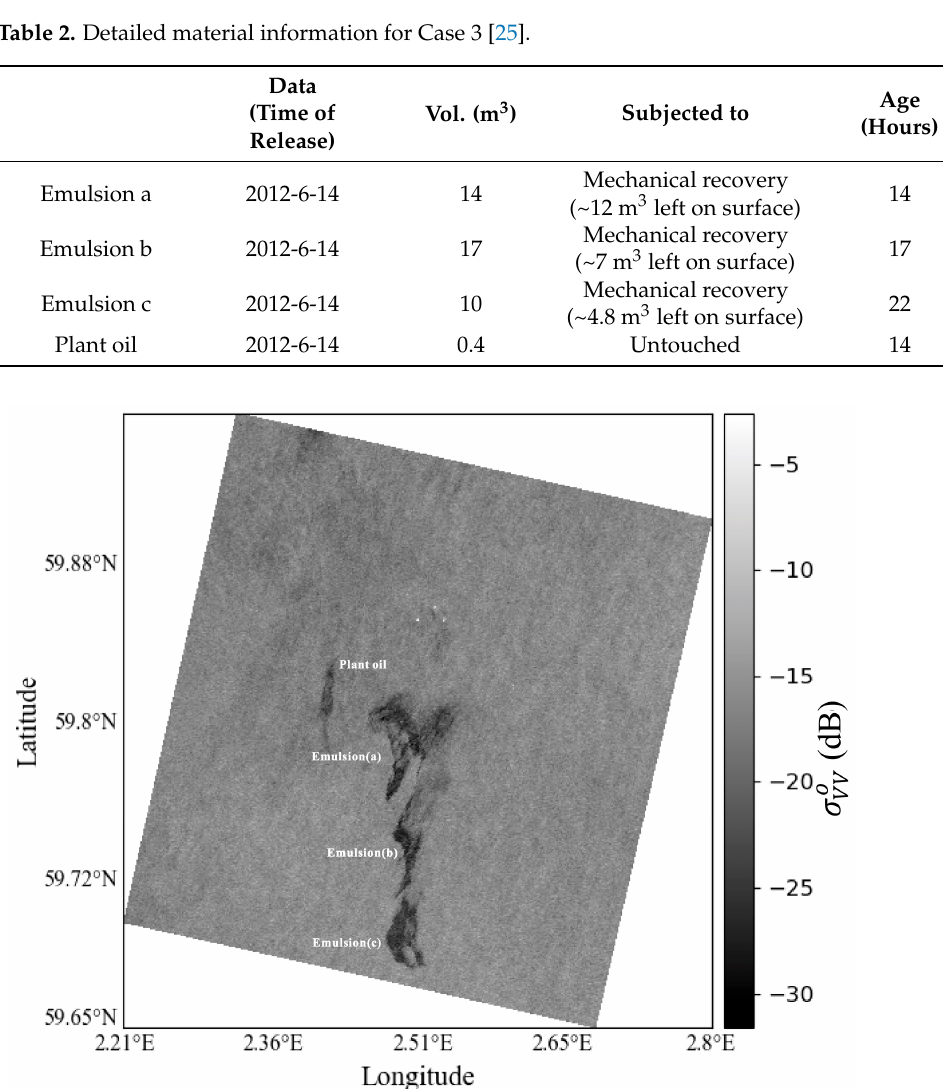
Figure 2. Detailed material information for Case 3 on preprocessed σ 0 vv image [25]. The SAR data selected in this paper are all unprocessed original RADARSAT-2 image data. These data need to be preprocessed to obtain image data that can meet the require- ments of this study.